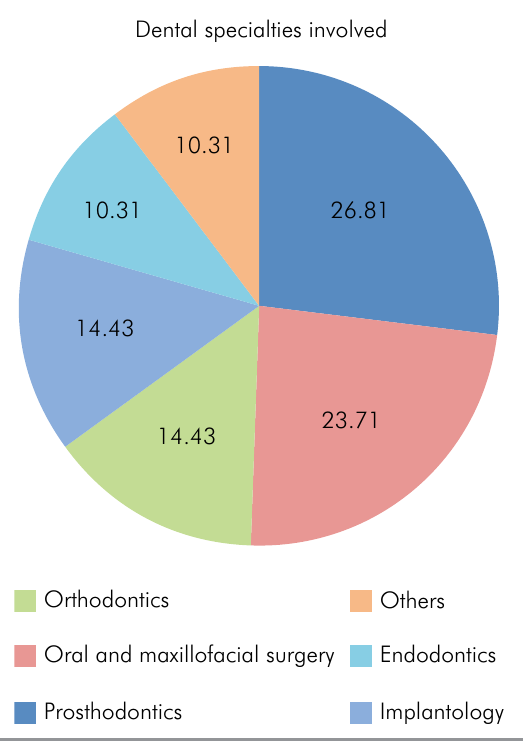
Figure. Percent distribution of the most frequently involved specialties in the lawsuits